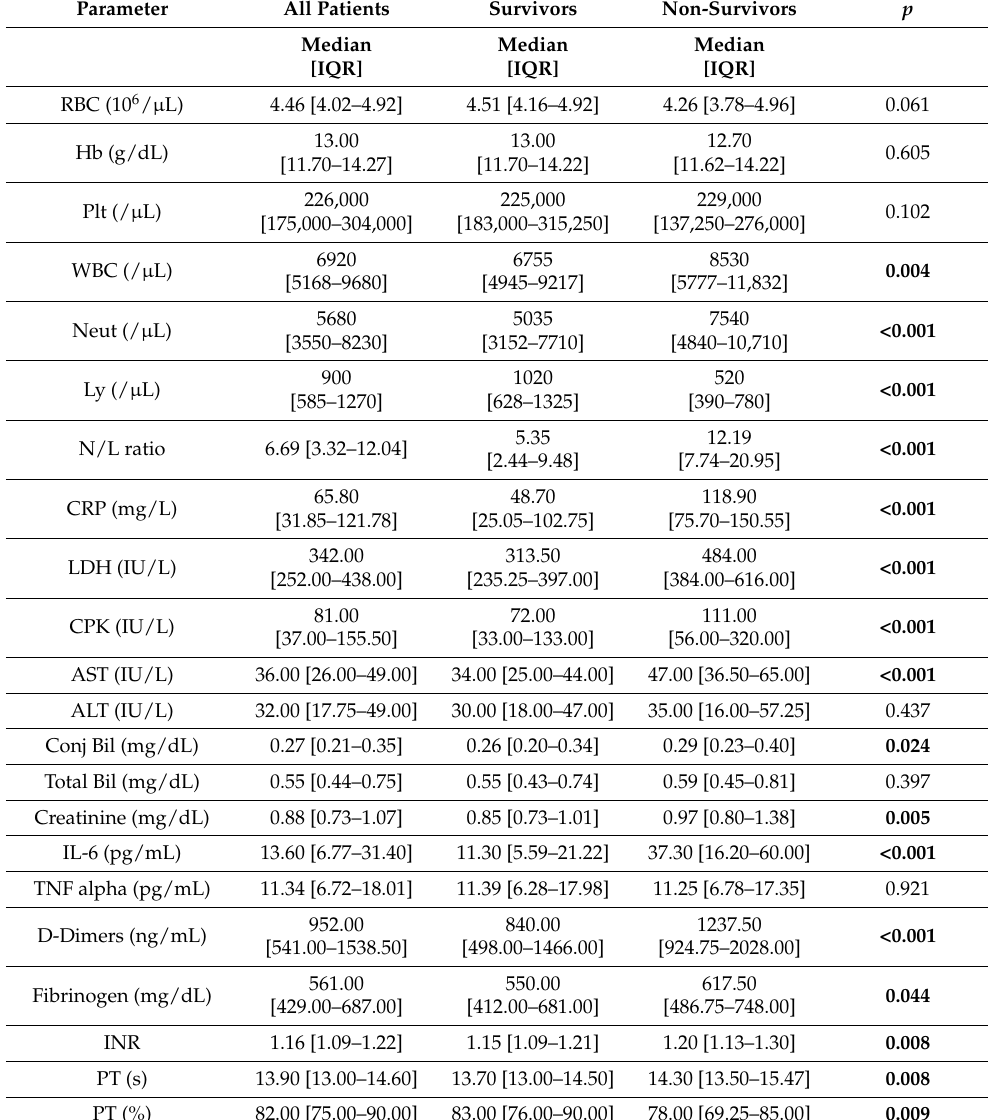
Table 2. Laboratory parameters of the study cohort, overall and after stratification for outcome (survivors and